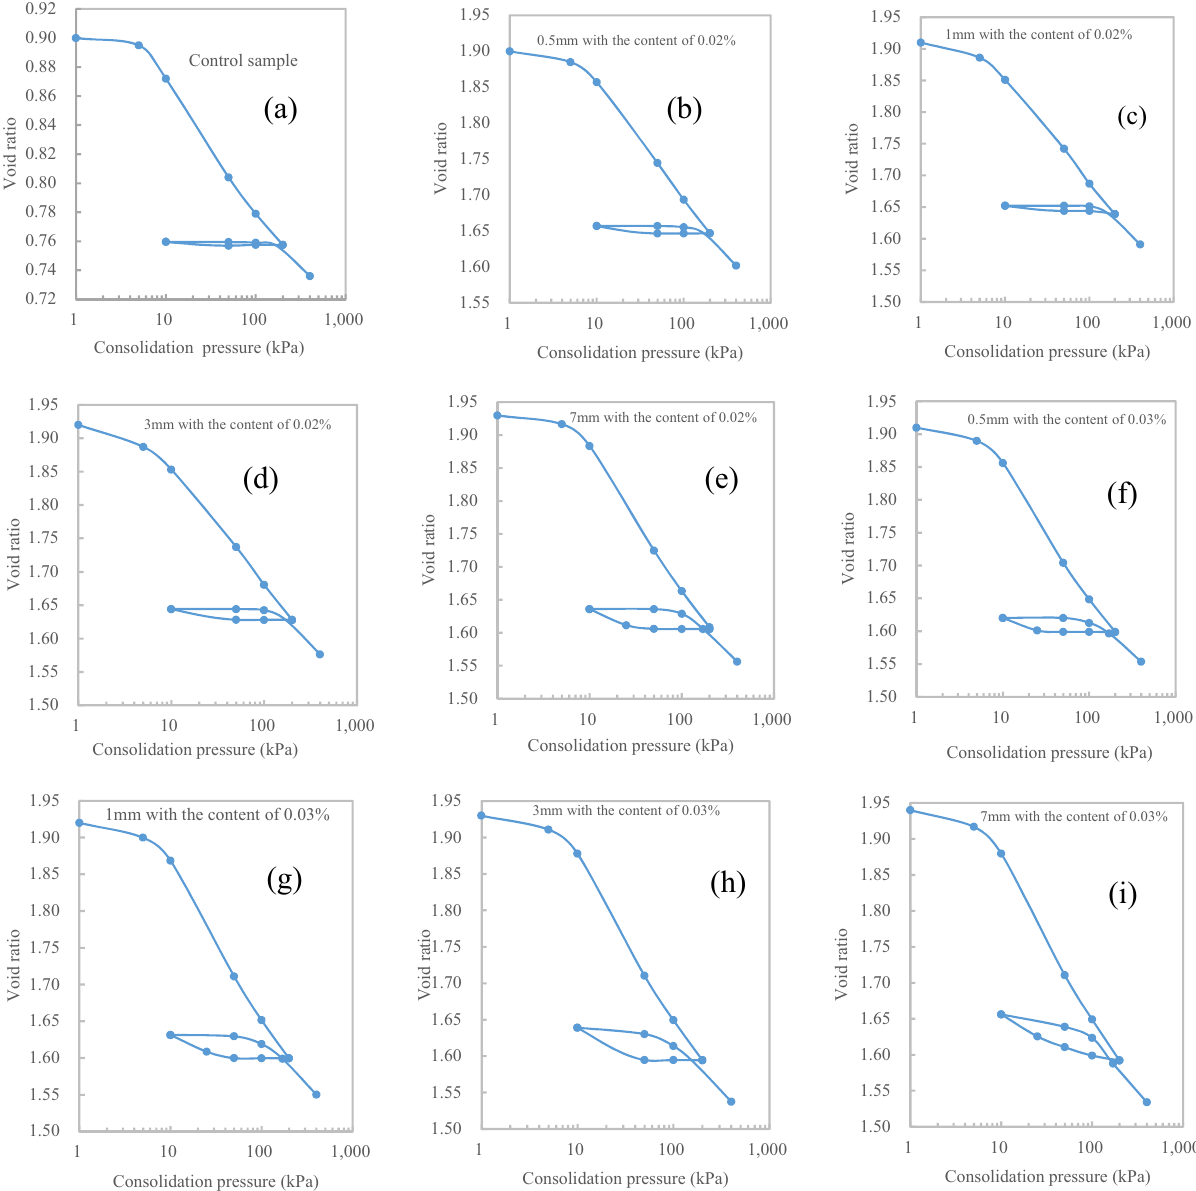
Figure 13: The relationship between consolidation pressure applied and the corresponding void ratio: ( a ) Control sample, ( b ) EPS beads of 0.5 mm with the content of 0.02%, ( c ) EPS beads of 1 mm with the content of 0.02%, ( d ) EPS beads of 3 mm with the content of 0.02%, ( e ) EPS beads of 7 mm with the content of 0.02%, ( f ) EPS beads of 0.5 mm with the content of 0.03%, ( g ) EPS beads of 1 mm with the content of 0.03%, ( h ) EPS beads of 3 mm with the content of 0.03%, and ( i ) EPS beads of 7 mm with the content of 0.03%. Note: Void ratio is a dimensionless quantity, being an absolute